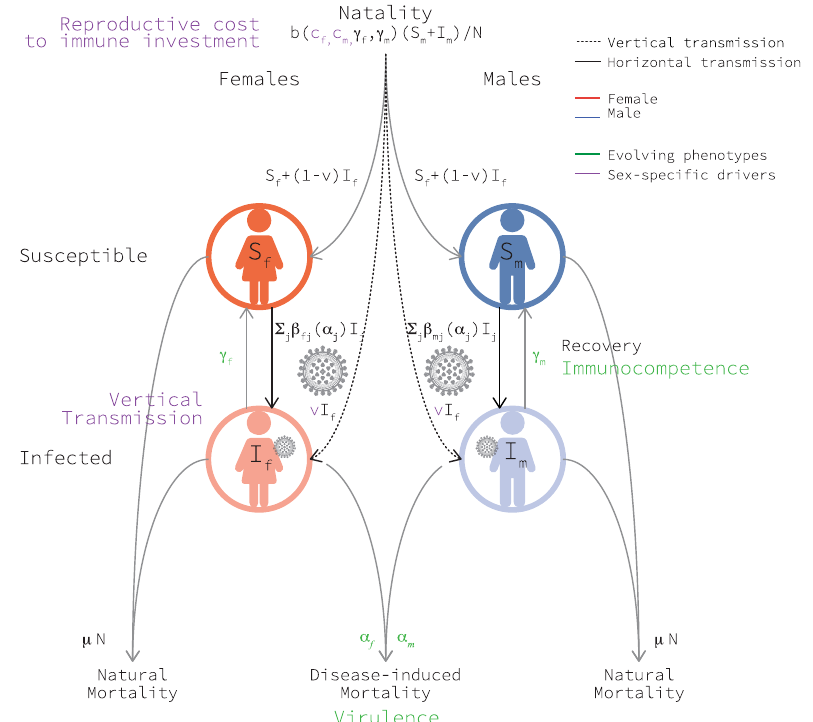
represent the fl ow rate. Evolving phenotypes and drivers of their evolution are indicated in green and purple, respectively. Source data are provided as a Source Data fi